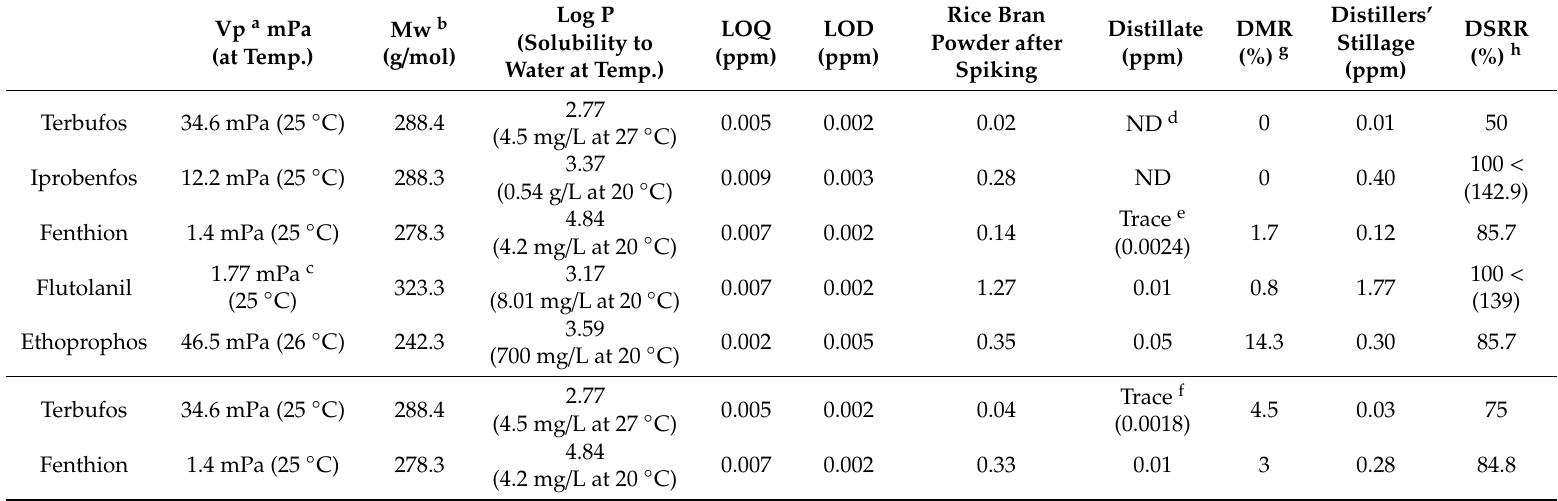
Table 2. Content (ppm), distillate migration rate (%, DMR), and distillers’ stillage residual rate (%, DSRR) of contaminated pesticides from the single-stage distillation